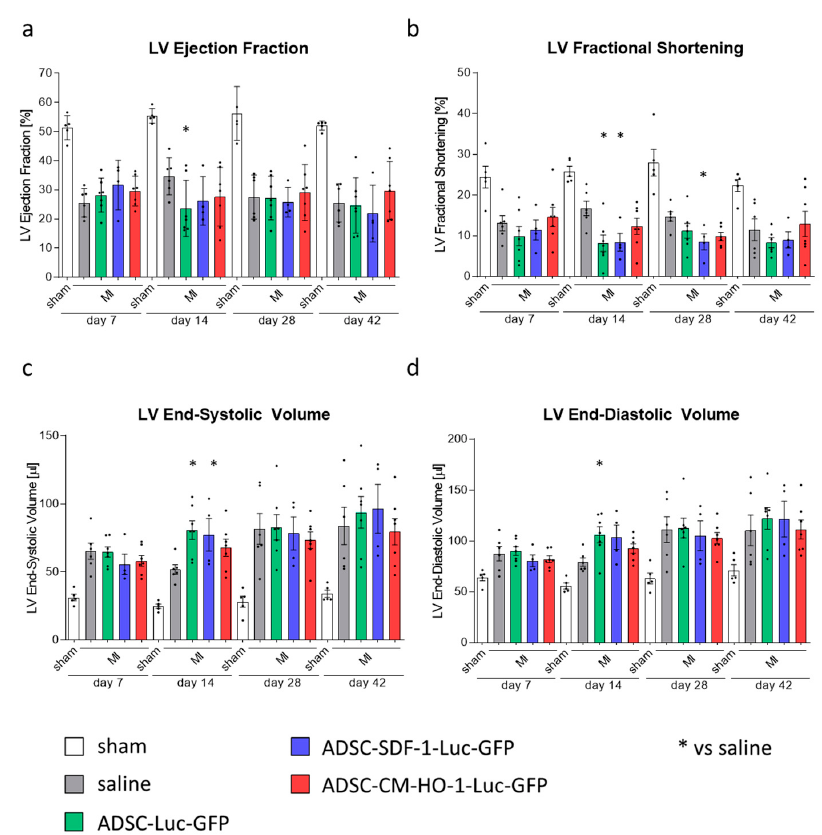
Figure 3. No improvement of heart function after administration of genetically modified ADSCs.